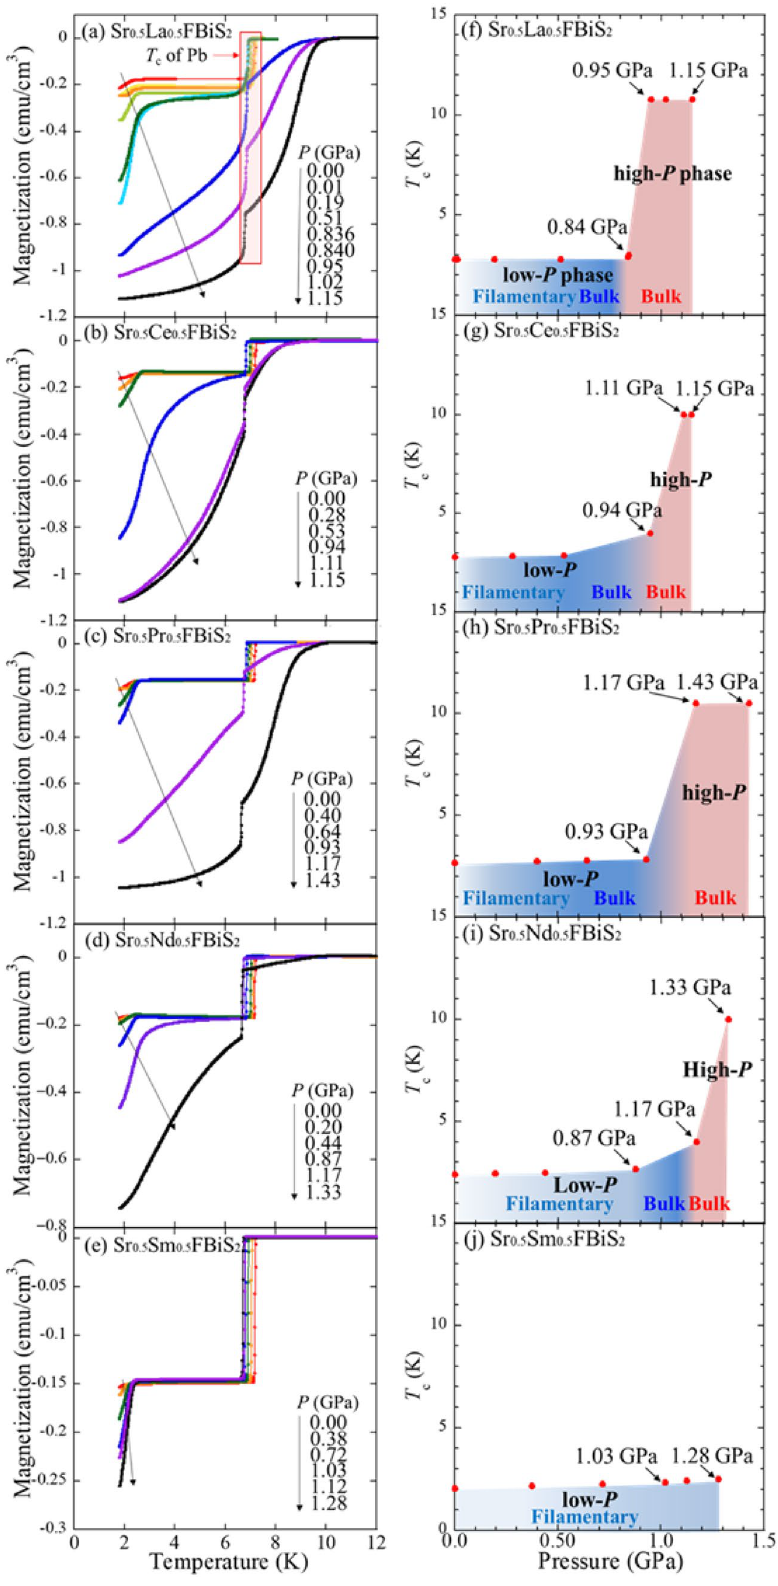
Figure 5. ( a – e ) Temperature dependences of magnetization under various pressure ( P La = 0, 0.01, 0.19, 0.51, 0.836, 0.840, 0.95, 1.02, and 1.15 GPa; P Ce = 0, 0.28, 0. 53 0.94, 1.11, and 1.15 GPa; P Pr = 0.0, 0.40, 0.64, 0.93, 1.17, and 1.43 GPa; P Ndr = 0.0, 0.20, 0.44, 0.87, 1.17, and 1.33 GPa; P Sm = 0.0, 0.375, 0.716, 1.03, 1.12, and 1.28 GPa) for Sr 0.5 RE 0.5 FBiS 2 ( RE : La, Ce, Pr, Nd, and Sm), ( f – j ) pressure dependence of T c for Sr 0.5 RE 0.5 FBiS 2 ( RE : La, Ce, Pr, Nd, and Sm) when a magnetic field of 10 Oe was applied for all samples. The superconducting transition around 7 K indicates the superconducting transition of Pb